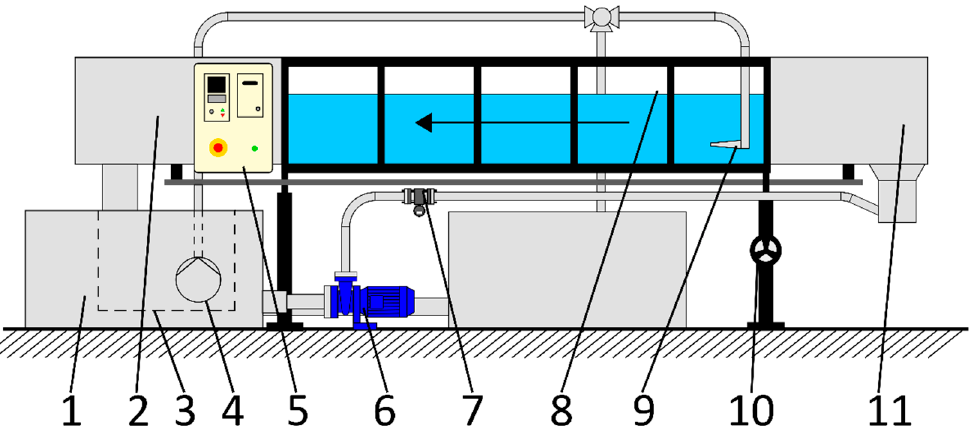
Figure 3. HM 162 experimental flume: 1—water tank, 2—water outlet element, 3—sediment screen basket, 4—sediment pump, 5—PLC (switch box), 6—centrifugal pump, 7—flow rate sensor, 8—open ‐ channel test section, 9—particle (sediment) inlet, 10—inclination adjustment element, 11—wa ‐ ter inlet element.